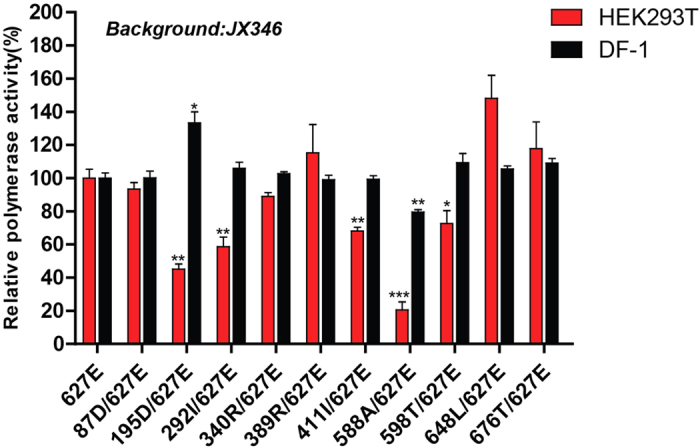
Polymerase activities of the JX346 PB2 with single or double substitutions.Human 293T or avian DF-1 cells were co-transfected with plasmids encoding the JX346 PB1, PA, NP, and PB2-627E or PB2 with double substitutions, together with a firefly luciferase reporter plasmid (driven by a human or an avian polymerase I promoter for use in human or avian cells, respectively), and a Renilla luciferase reporter plasmid (internal control). Cells were incubated for 24 h at 37 °C (HEK293T) or 39 °C (DF-1), and then firefly and Renilla luciferase activities were measured using a dual-luciferase assay. Polymerase activity was calculated by normalizing the firefly luciferase activity to the Renilla luciferase activity. The polymerase activity of the single 627E substitution in PB2 was set to 100% and the data are shown as mean relative polymerase activities ± SD (n = 3). (*p < 0.05, **P < 0.01, ***P < 0.001), according to a one-way ANOVA followed by a Dunnett’s test.